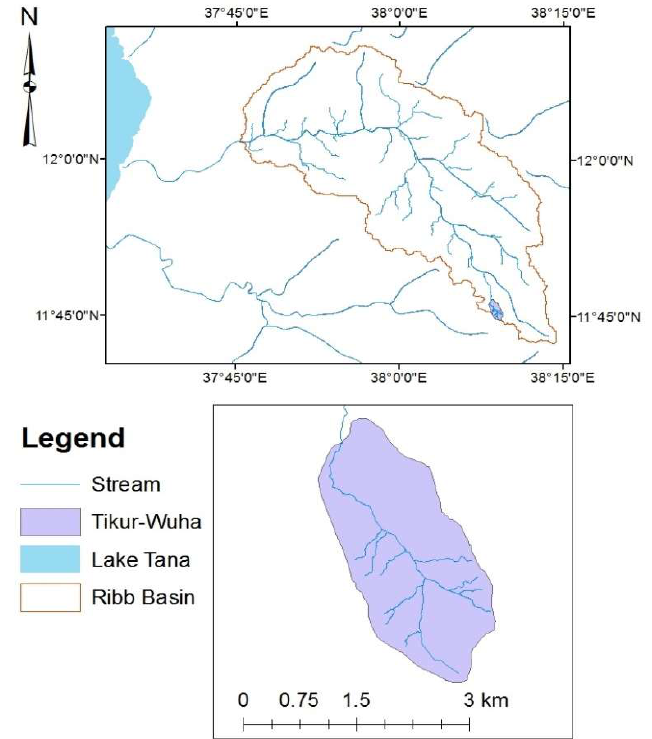
Figure 1. Map of the Tikur-Wuha watershed in the headwaters of the Ribb, which drains to Lake Tana.